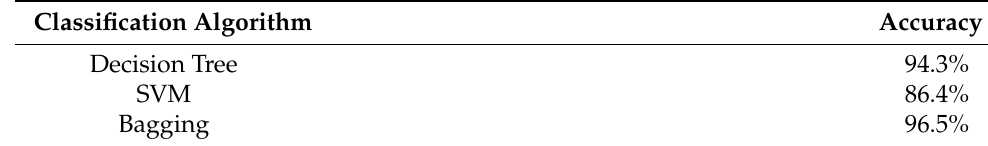
Table 4. The accuracy of classification algorithm.